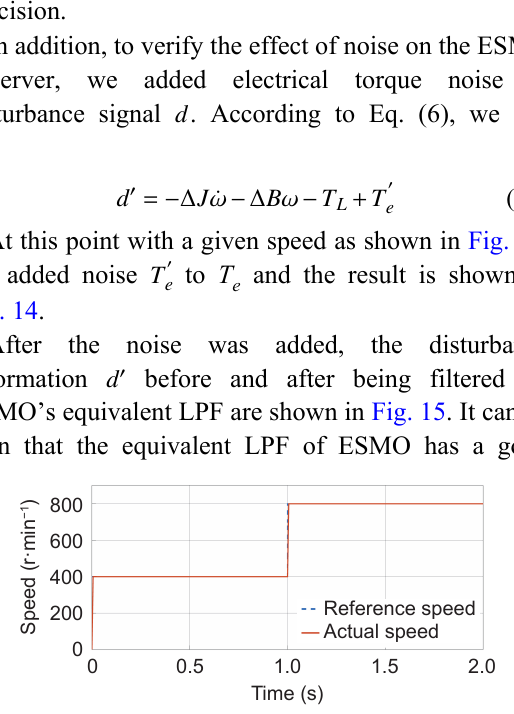
Fig. 13 Waveform of the given speed changing from 400 r·min −1 to 800 r·min −1 .